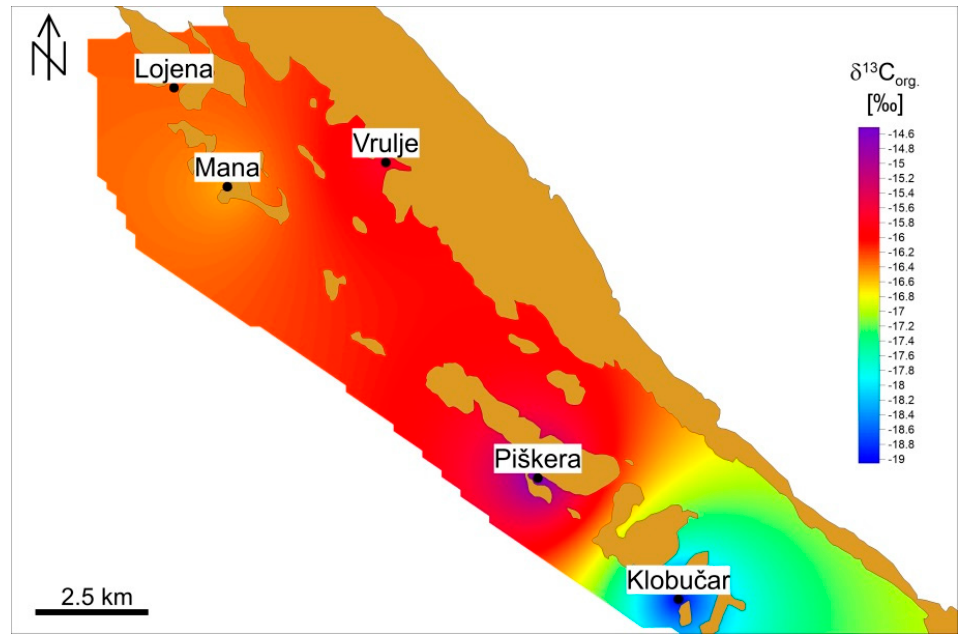
Figure 7. Distribution map of the δ 13 C values of H. trunculus .